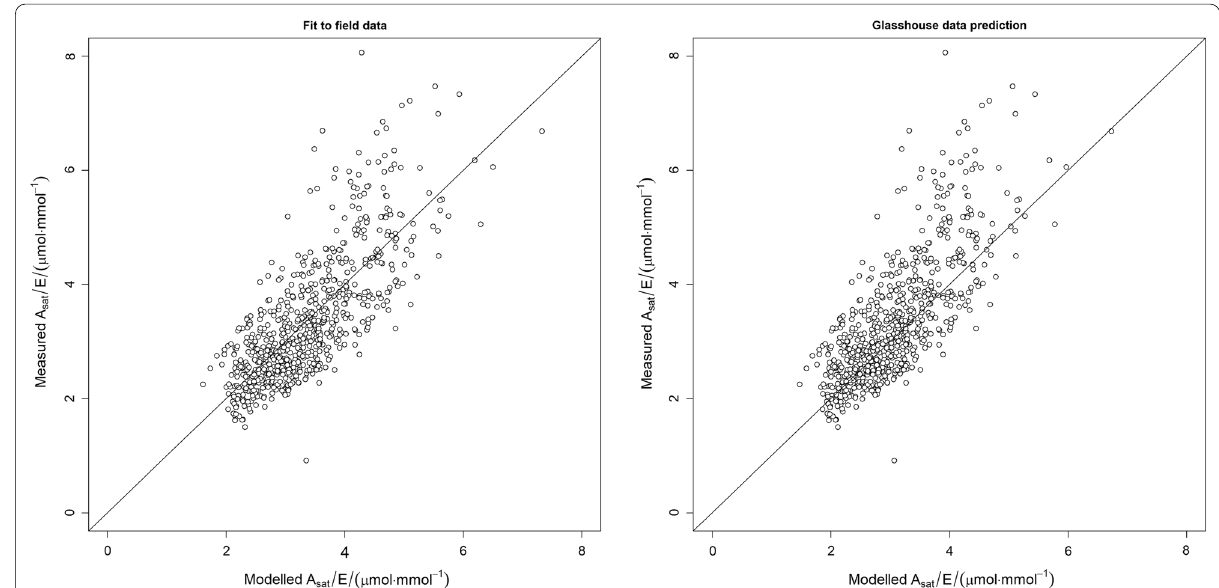
Fig. 4 Comparison of modelled and measured A sat / E using Eq. (2) where g 1 and k parameters are from a field data and b glasshouse data prediction from Duursma et al. (2013). Also shown are the 1:1 lines (black). a RMSE apply; MAD =